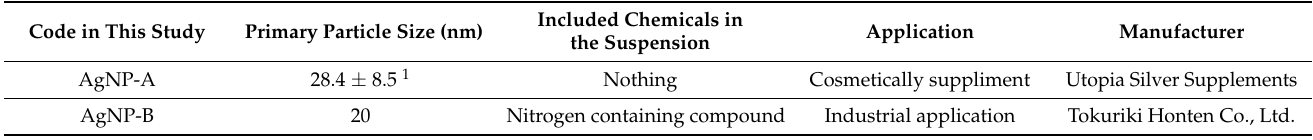
Table 1. Properties of silver nanoparticles employed in this